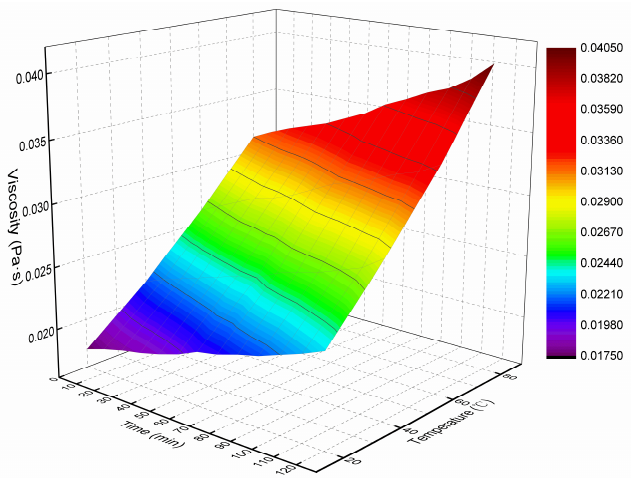
Figure 17. The relationship of viscosity-temperature-time of the ordinary cement slurry.